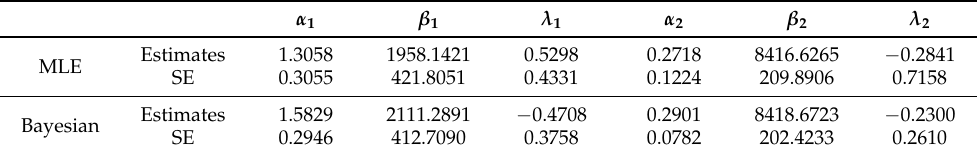
Table 11. MLE and Bayesian estimation for competing risk